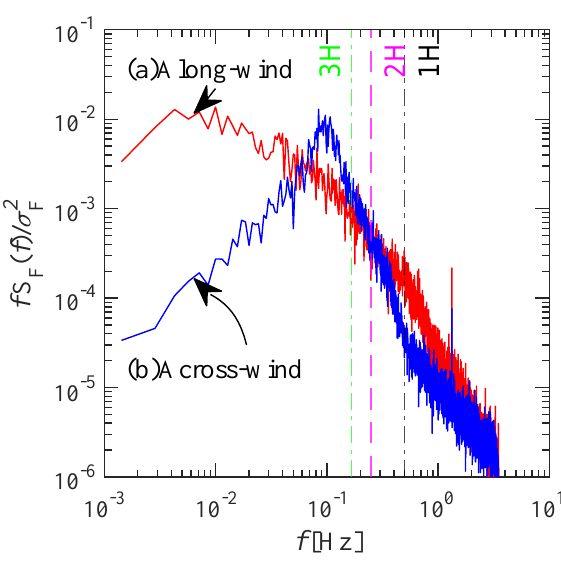
Figure 11. Normalized PSD of 1st modal